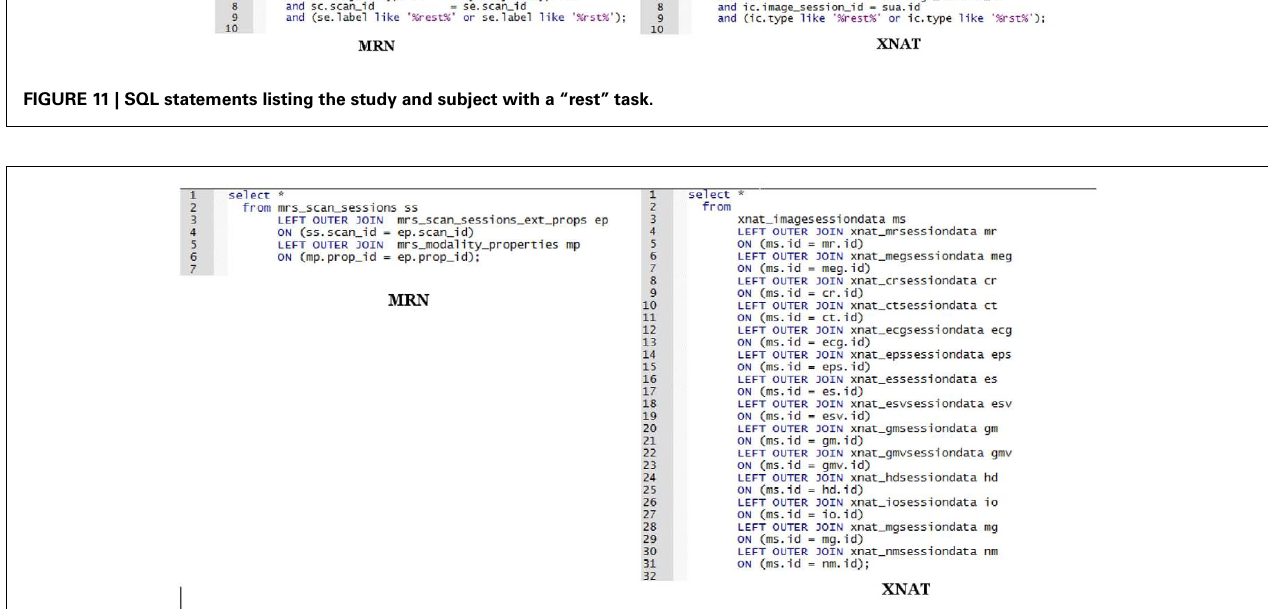
FIGURE 12 | Comparison of SQL statements to retrieve all scans, all